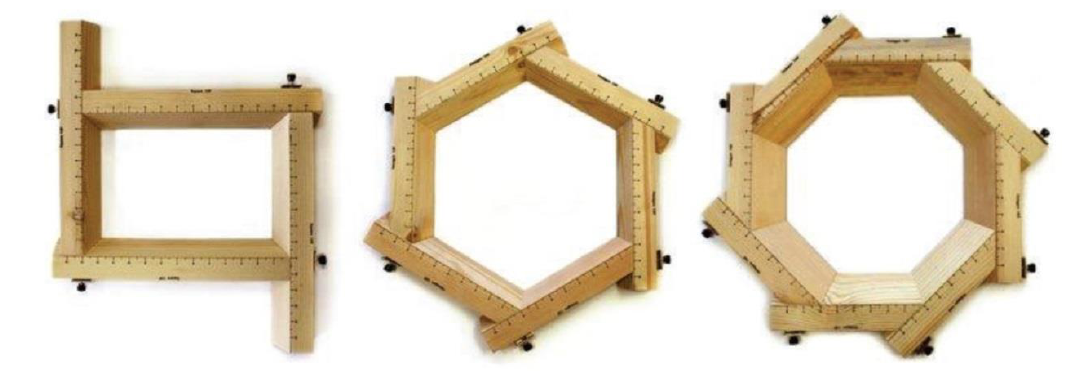
Fig. 13 Moulds with adjustable edge lengths by Bamboo Tools for quadrangular, hexagonal and octagonal shapes.